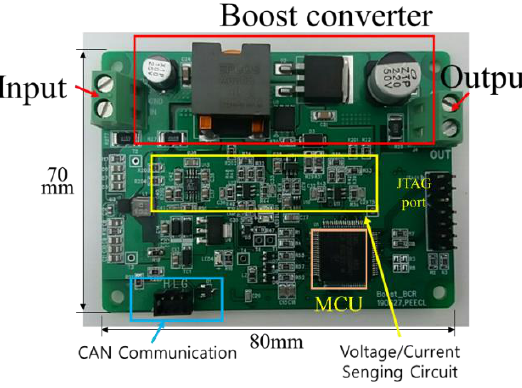
Figure 18. Experimental setup for laser wireless power transmission.